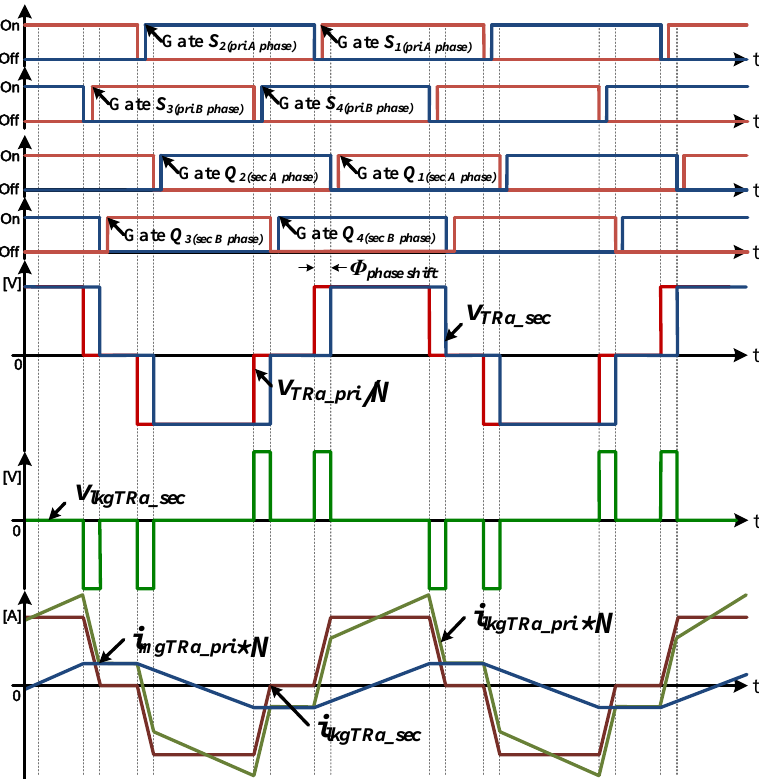
Figure 4. The voltage and current waveforms of the primary and secondary sides of phase A using the proposed phase shifting technique.